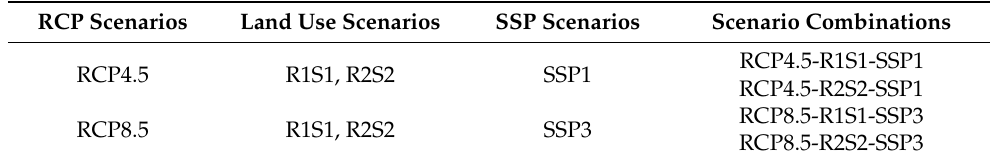
Table 2. Scenarios combinations for projected groundwater